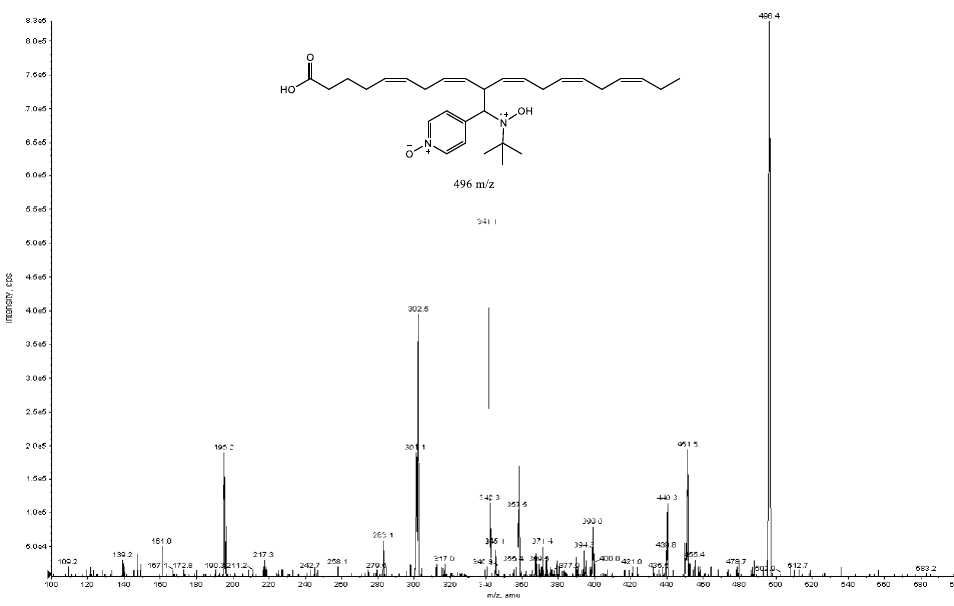
Figure 3. ESI MS/MS spectra and structure of EPA-POBN adduct.